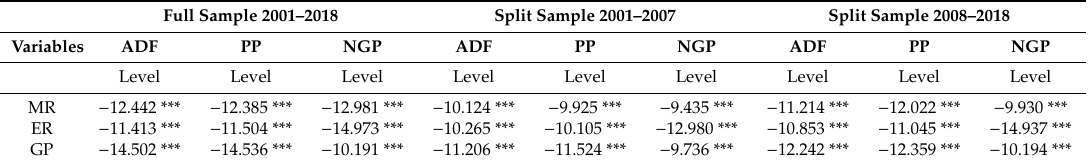
Table 3. Unit root test